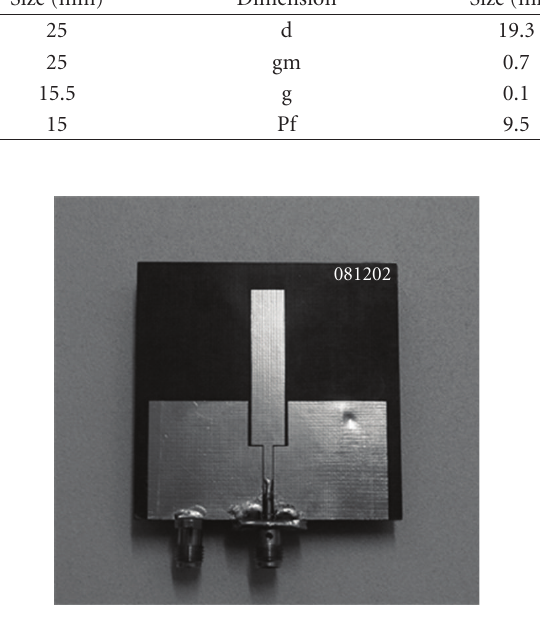
Figure 8: The prototype picture.